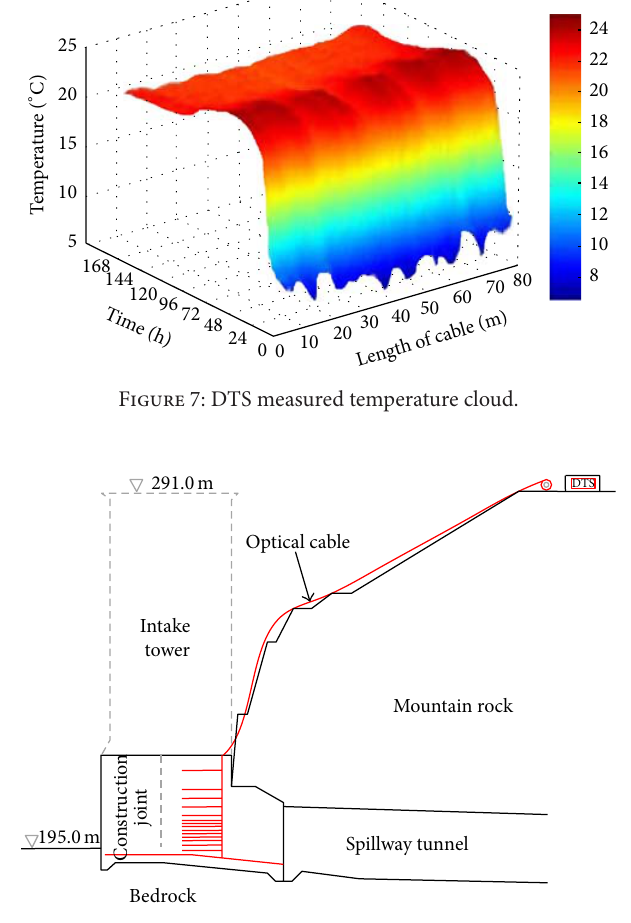
Figure 8: Overall layout of cable in the lateral view.